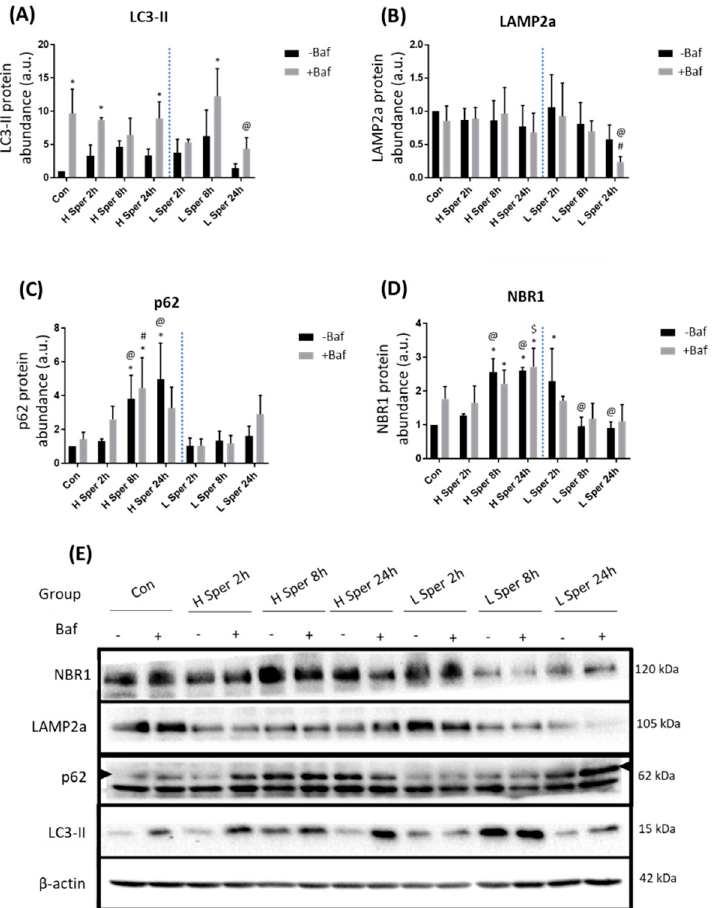
Figure 2. Western blot analysis following 20 µM (H Sper) and 5 µM (L Sper) spermidine incubation over 24 h in the presence (+Baf) and absence (-Baf) of bafilomycin. N = 3. ( A ) LC3-II protein levels. * p < 0.05 vs. Con, @ p < 0.05 vs. 24h +Baf L Sper. ( B ) LAMP2a protein levels. # p < 0.05 vs.